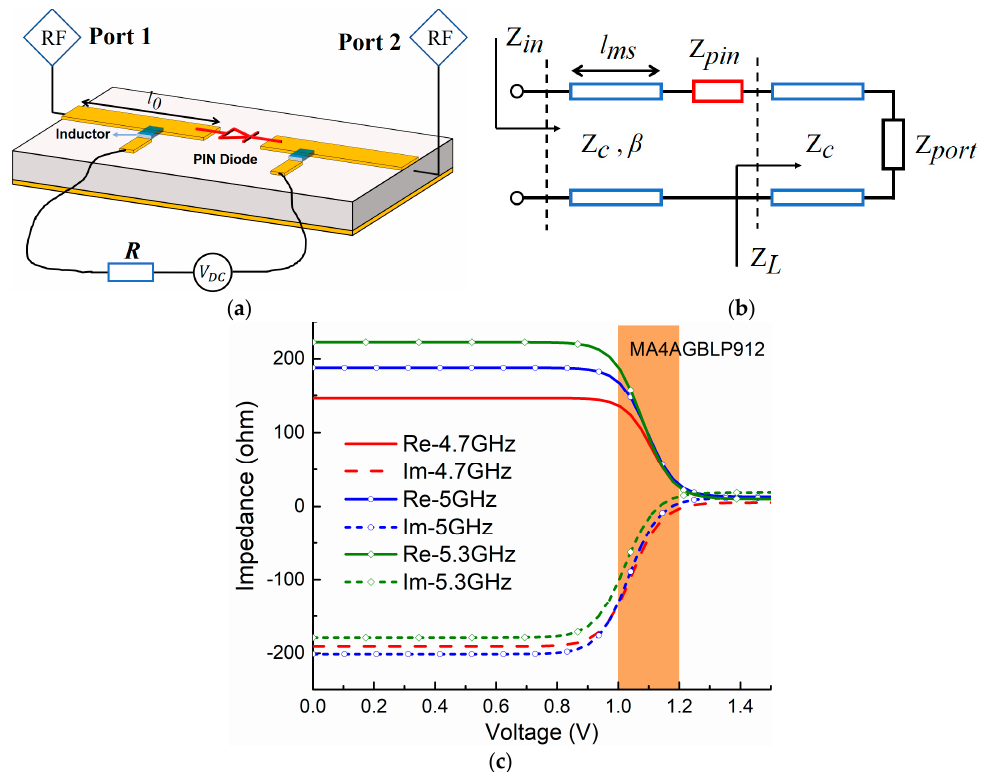
Figure 2. ( a ) Measurement setup and ( b ) its equivalent circuit model for investigating the nonlinear zone of PIN diode A (MACOM MA4AGBLP912); ( c ) extracted equivalent impedance including resistance and reactance according to different voltages actuated to the PIN diode.